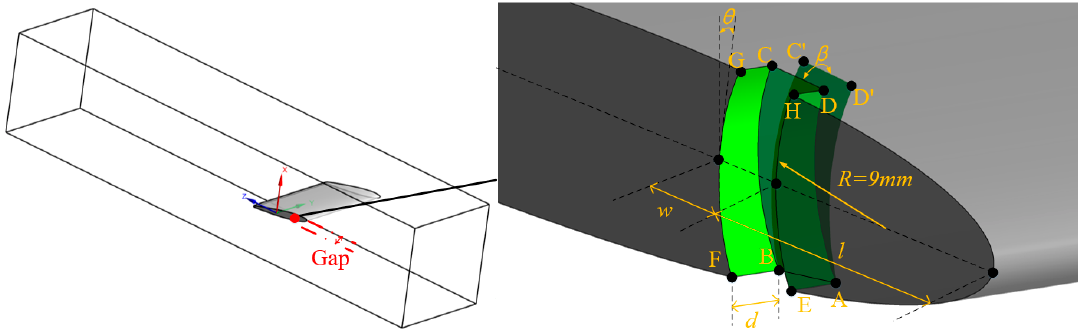
Figure 2. Parametric bending shrinkage groove (BSG).